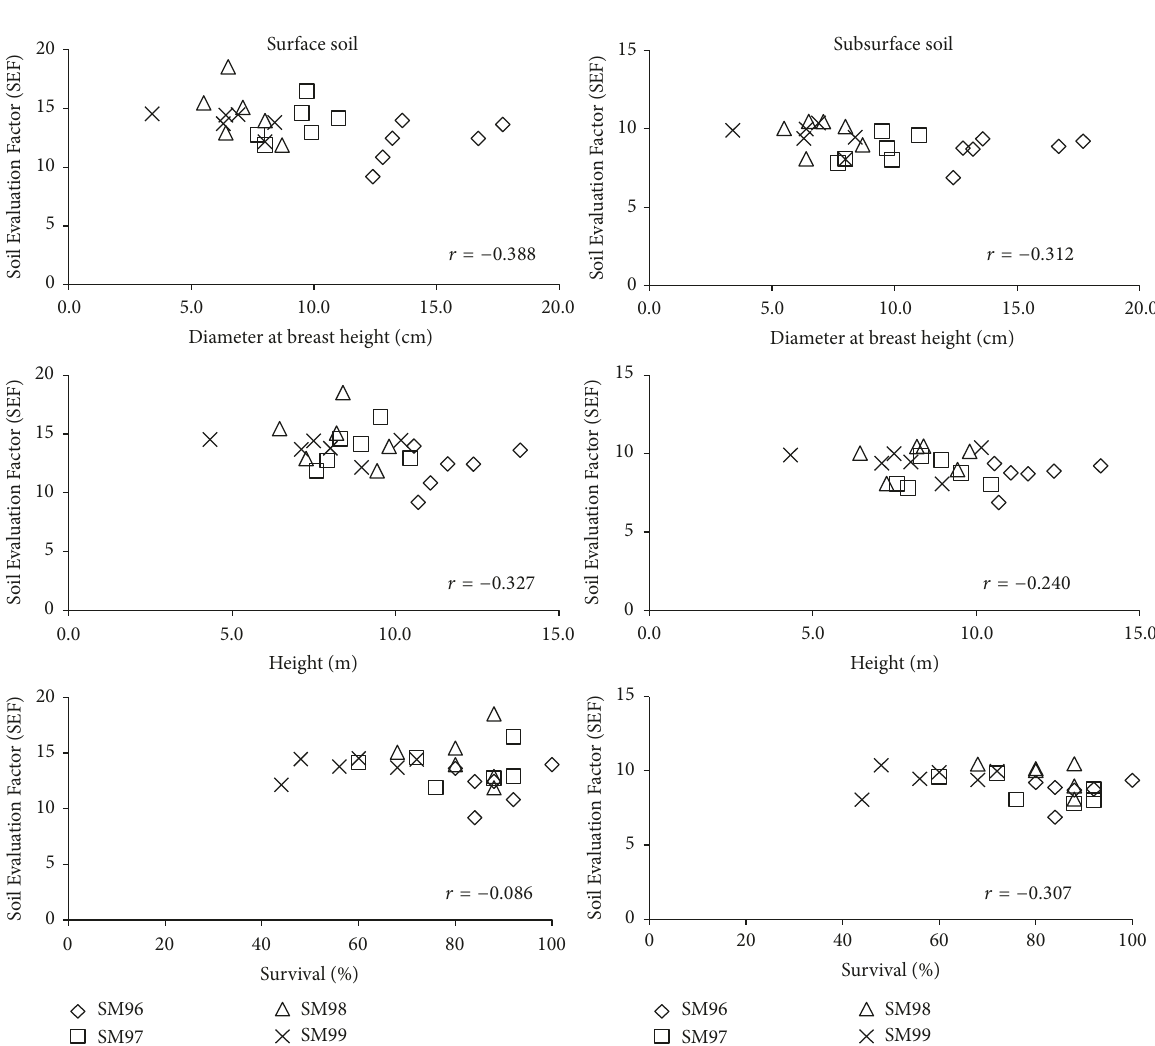
Figure 5: Relationship between diameter at breast height (DBH), height, and percentage of survival with Soil Evaluation Factor (SEF) derived from surface and subsurface soils.